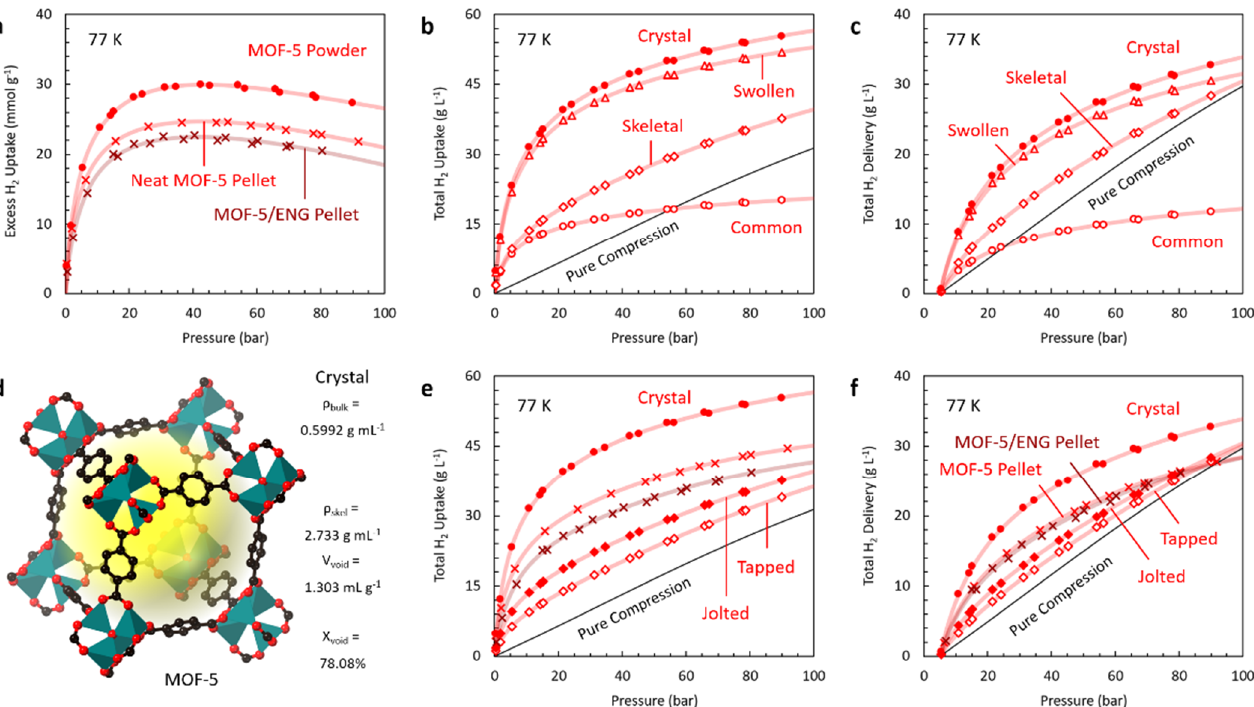
Figure 2. Representative measurements and methods of calculation of volumetric H 2 storage via physical adsorption. ( a ) Excess H 2 uptake on MOF-5 at 77 K: loose powder (used for crystal, tapped powder, and jolted powder analysis) compared to two representative pellets. ( b , c ) Total H 2 uptake and delivery on jolted MOF-5 powder under three different assumptions: common, skeletal, and swollen. The crystalline assumption is shown for comparison. ( d ) Crystal structure of MOF-5 and calculated structural parameters (2.4 Å diameter probe). ( e , f ) Total H 2 uptake and delivery on densified variants of MOF-5: tapped powder, jolted powder, and two representative pellets, all under the skeletal assumption. The crystalline assumption is shown for comparison. Excess H 2 adsorption data were obtained from the following references: MOF-5 powder [36], neat pellet (0.52 g mL −1 ) [37], and MOF-5/ENG pellet (5% ENG, 0.47 g mL −1 ) [37].